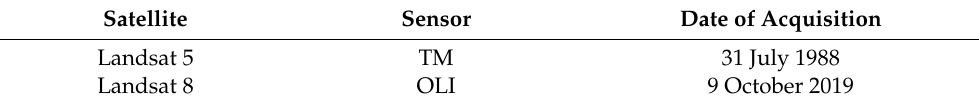
Table 1. Landsat data